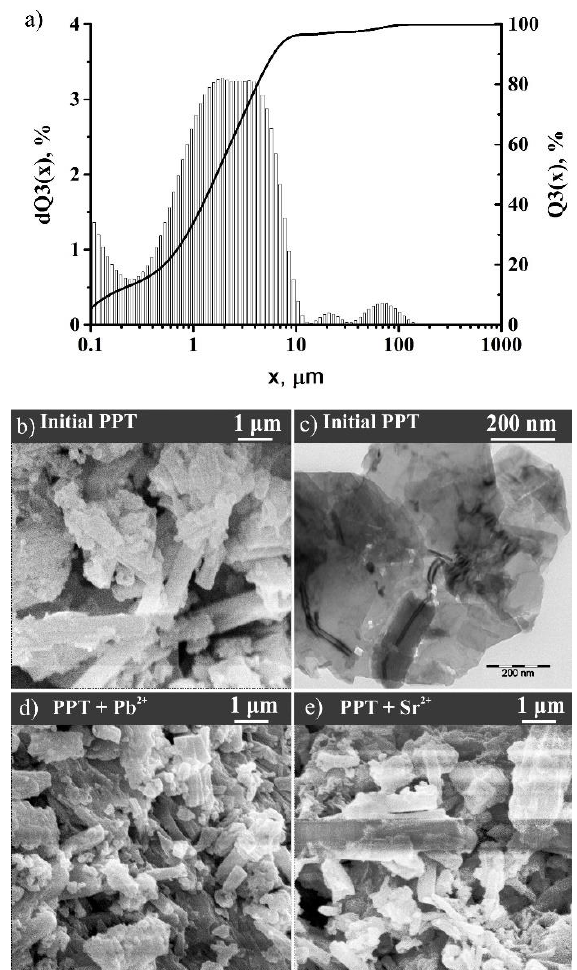
Figure 1. Particle size distribution of potassium polytitanates (PPT) before sorption ( a ); scanning electron microscope (SEM) ( b ) and transmission electron microscope (TEM) image ( c ) of PPT before sorption , and SEM image of PPT after sorption of Pb 2+ ( d ) and Sr 3+ ( e ).